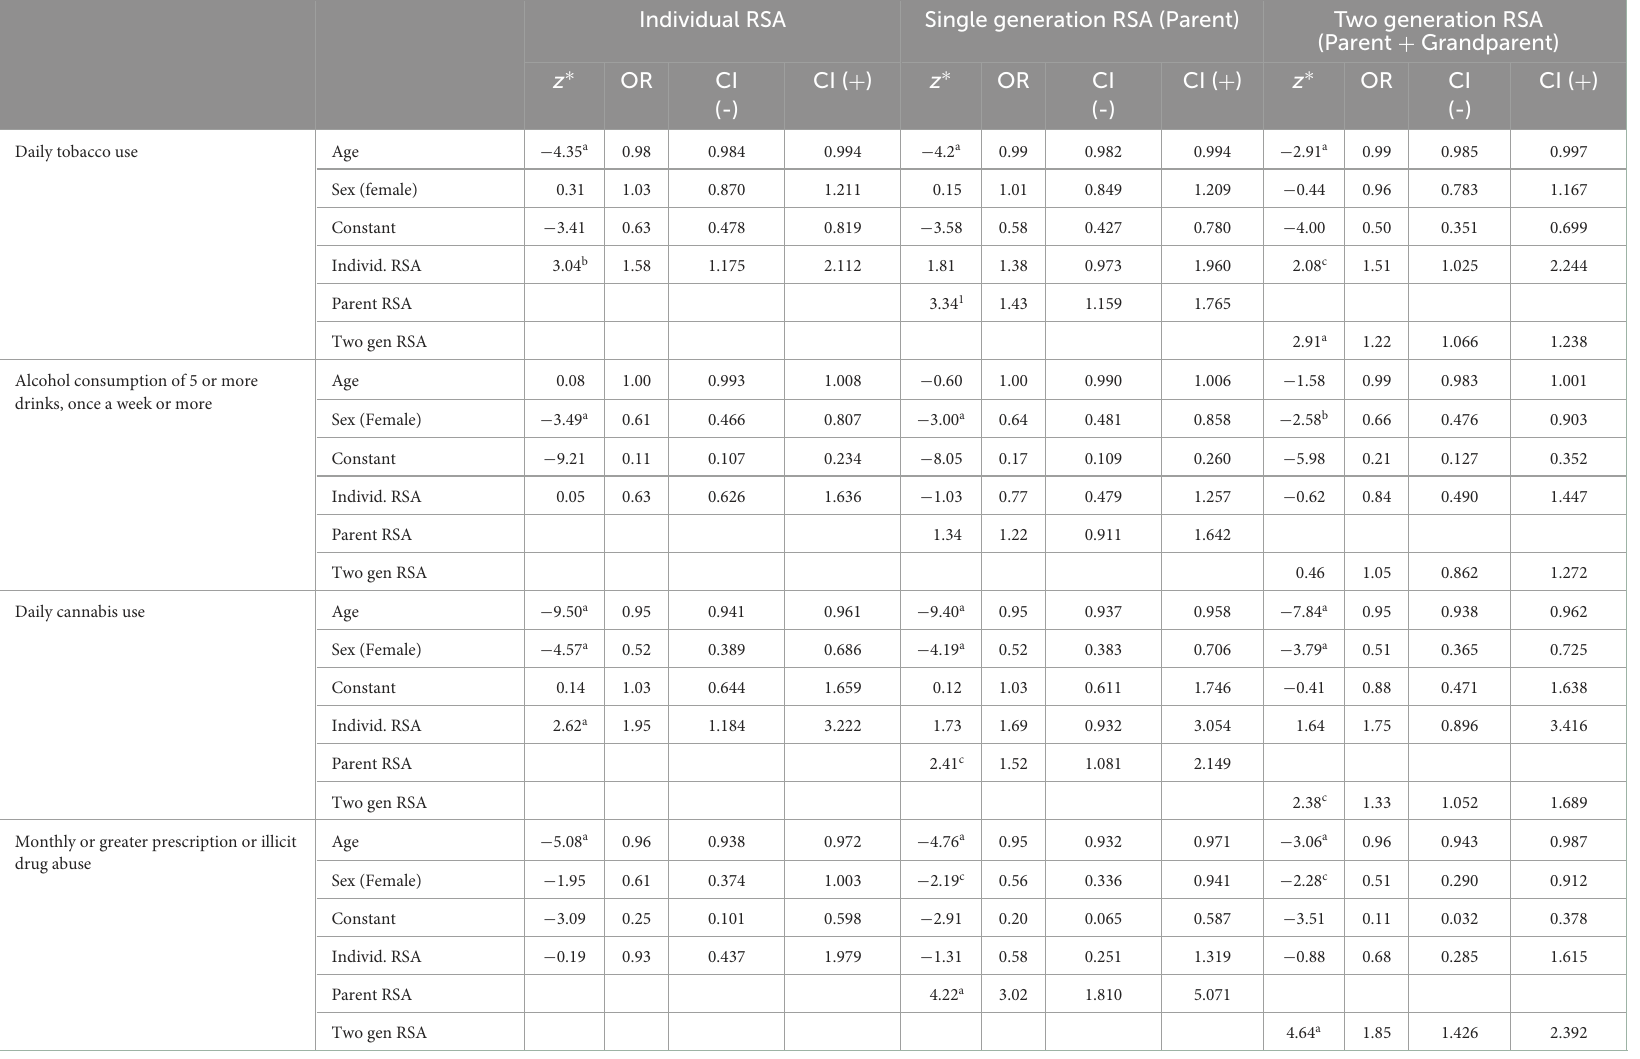
TABLE 3 Predictors of substance use frequency including individual, parent, and two-generation